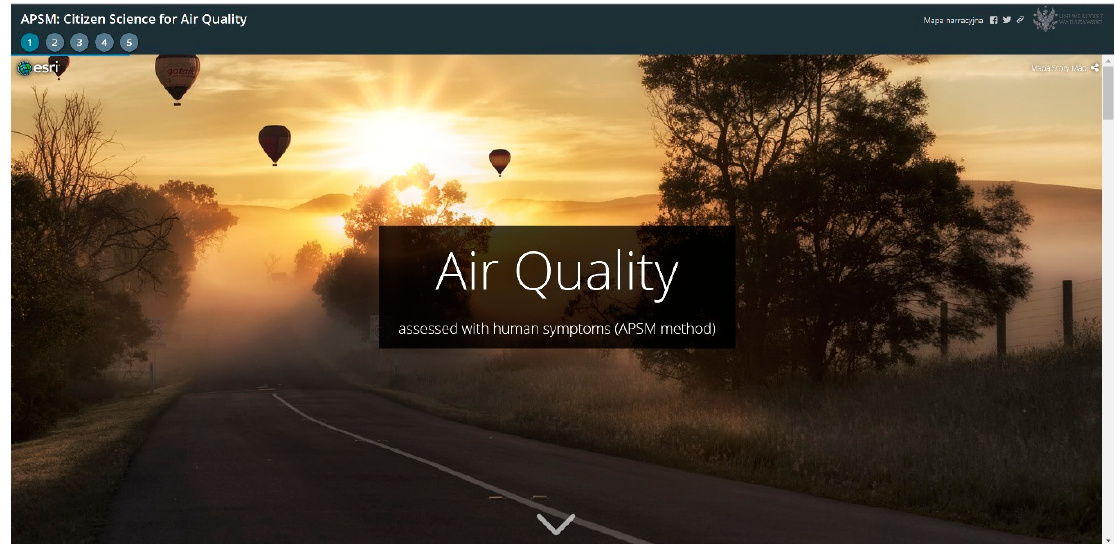
Figure A2. Web application for the APSM project: collection of five applications.